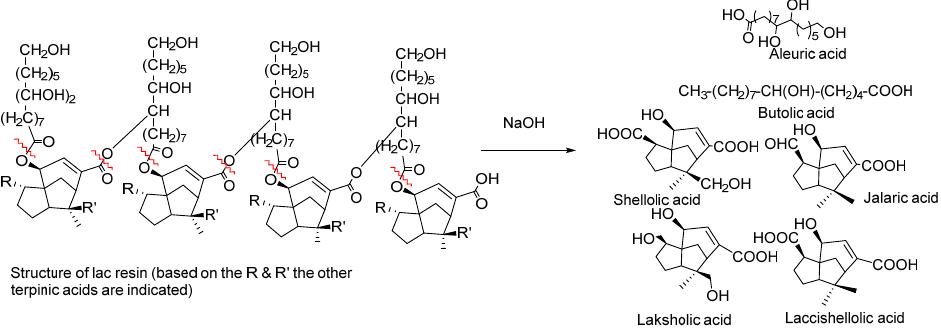
Figure 1. Chemical structure of lac resin and its hydrolysed products.